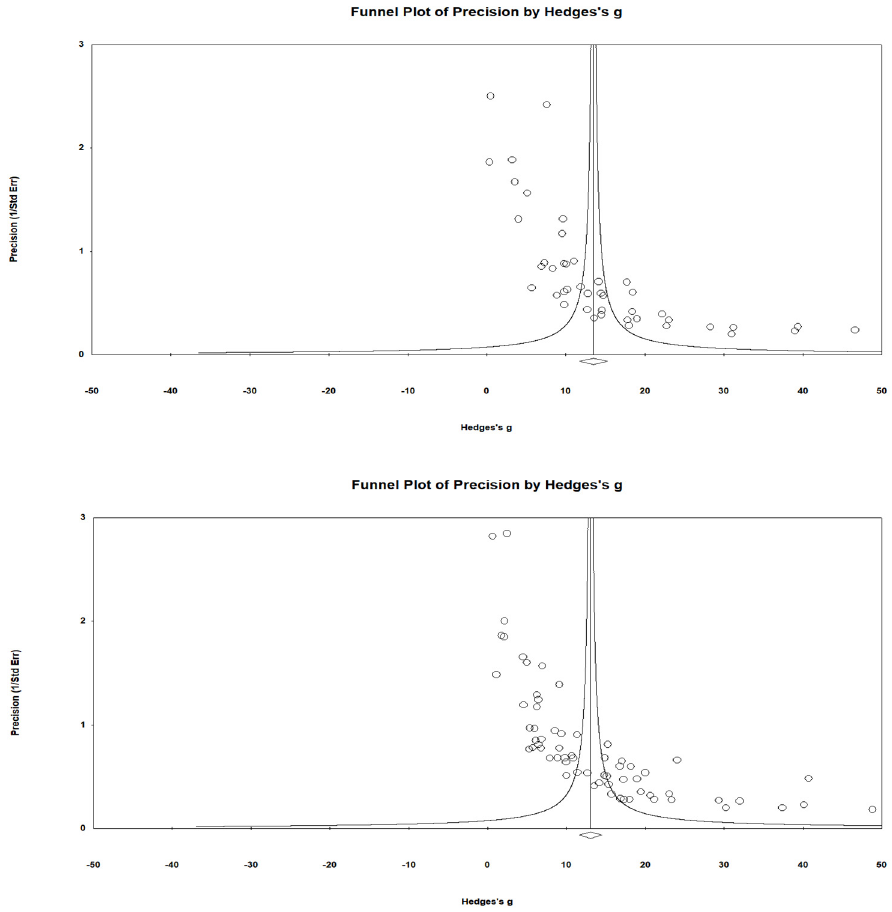
Figure 2. Funnel plot for testing publication bias and the validity of the results: depression ( Top ) and cognition ( Bottom ).